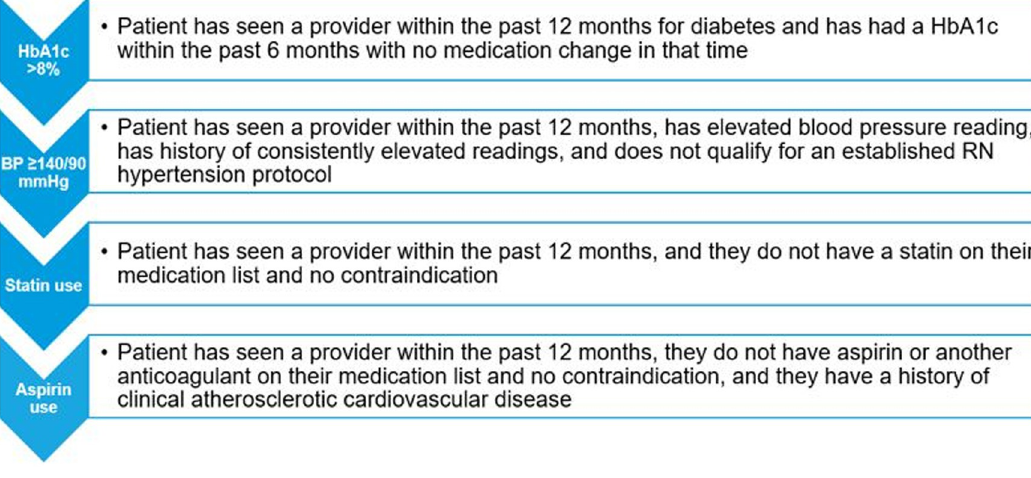
Fig 1. Criteria for pharmacist referral within enhanced primary care team model based on the D4 treatment goals.